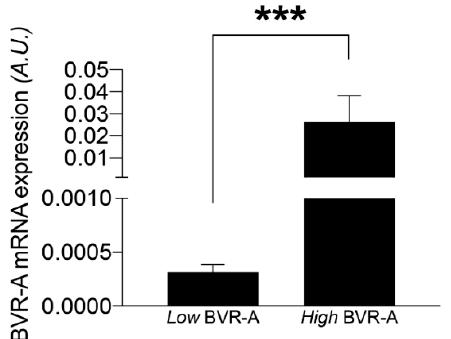
Figure 1. mRNA expression levels of BVR-A in VAT. Subjects were dived into two groups based on BVR-A mRNA expression levels below or above the median value (low and high BVR-A, respectively). Data are expressed as mean ± SEM, *** p < 0.0001 (Mann–Whitney). A.U., arbitrary units.